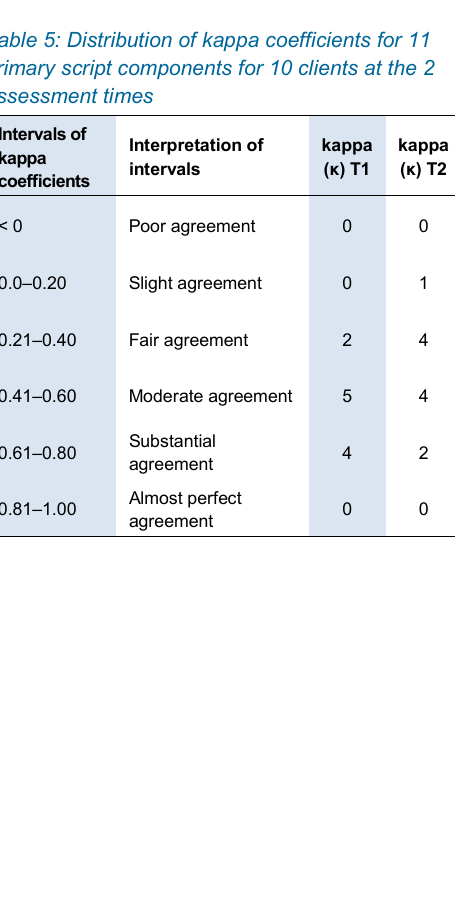
Table 6: Ranking of script components for 10 clients